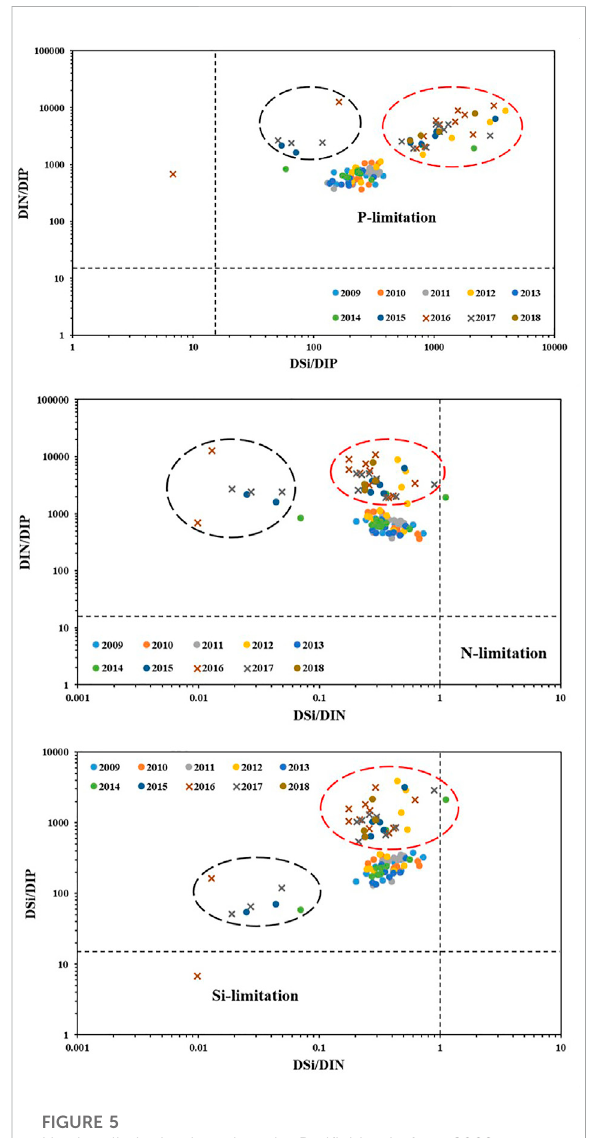
FIGURE 5 Nutrient limitation based on the Red fi eld ratio from 2009 to 2018 at LJ. Dotted lines mark the Red fi eld ratio of potential nutrient limitations (Si:N:P of 16:16:1). Black dotted circles indicate the summers of 2016 and 2017, and red dotted circles indicate the other seasons of 2016 and